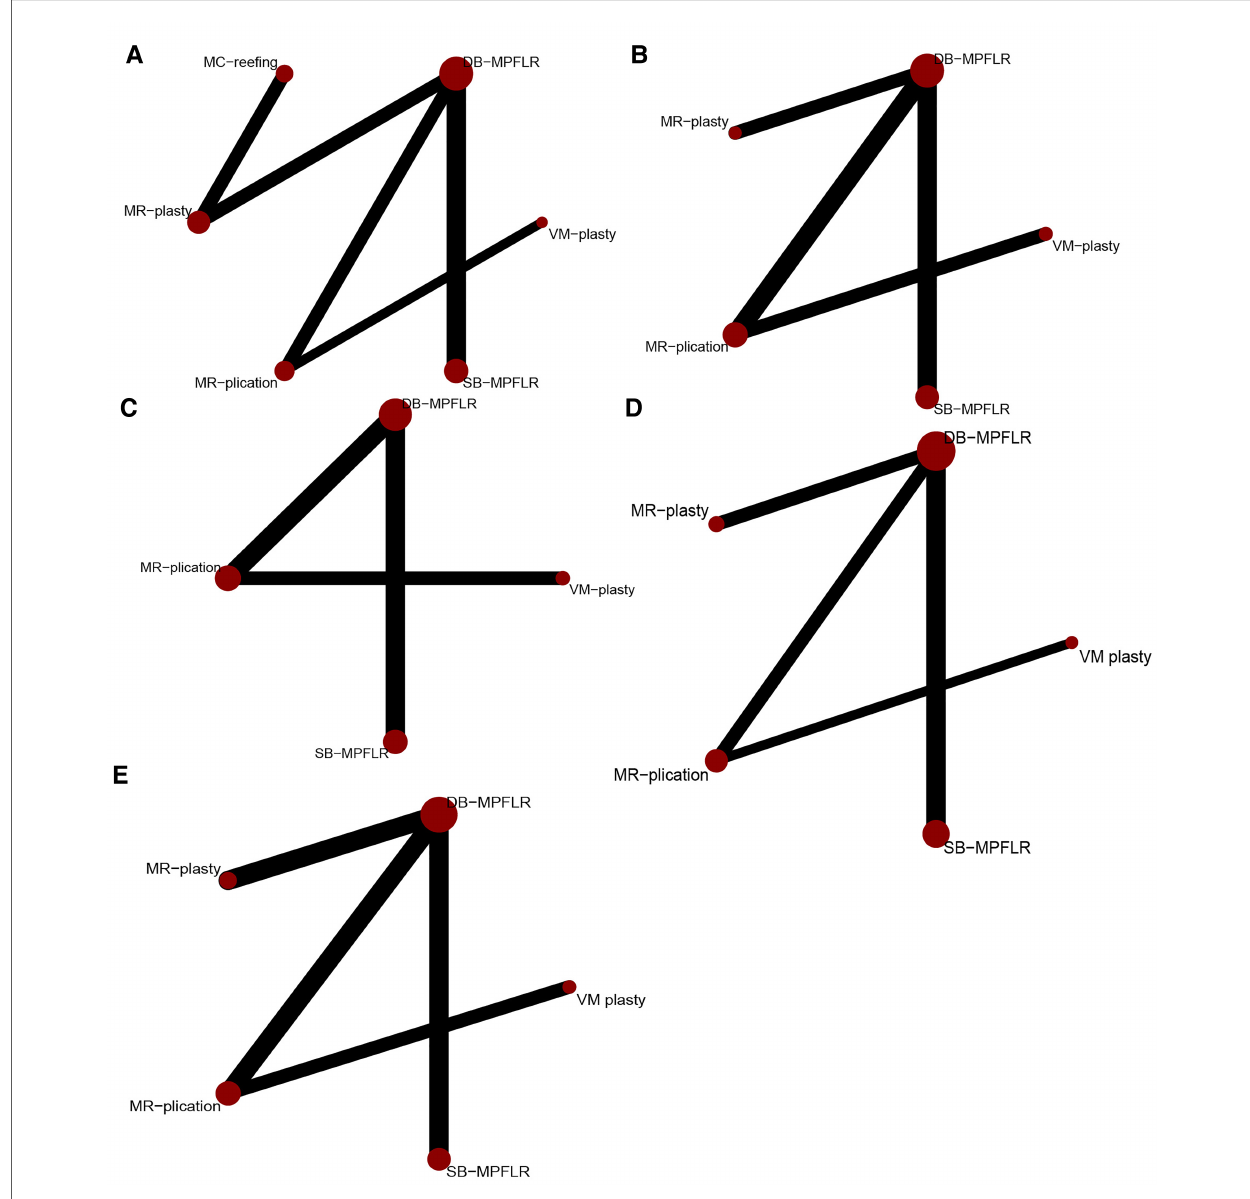
FIGURE 4 Network plot of treatment comparisons: ( A ) kujala score; ( B ) lysholm score; ( C ) IKDC score; ( D ) redislocation; ( E ) recurrent